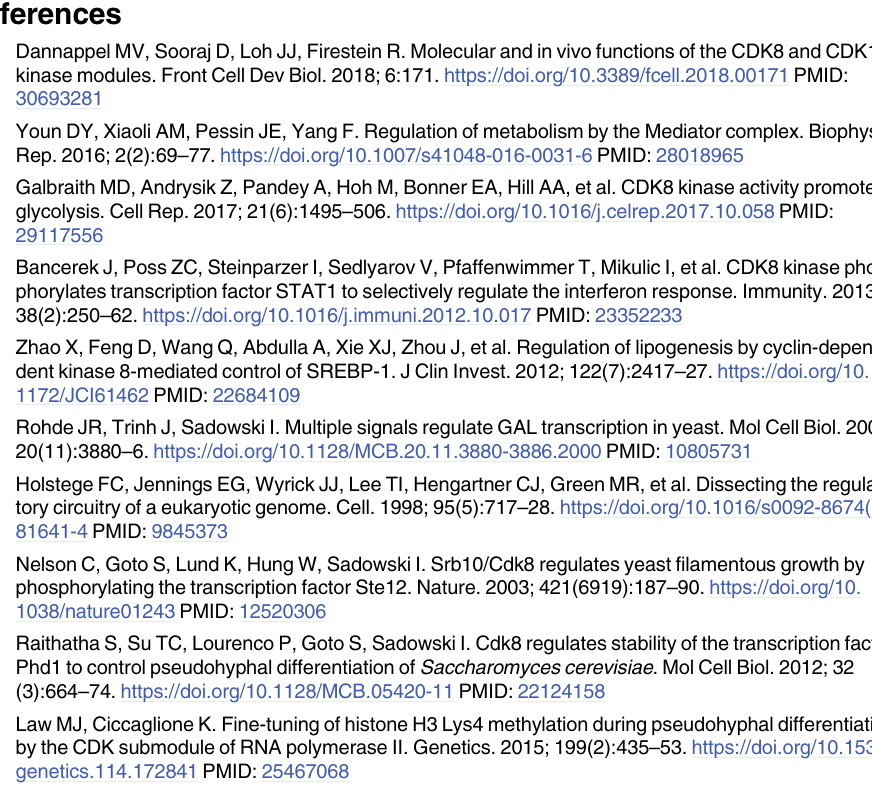
S4 Table. KEGG pathway enrichment analysis of transcripts altered in abundance in the ssn3 AS strain by 3-MB-PP1 treatment vs